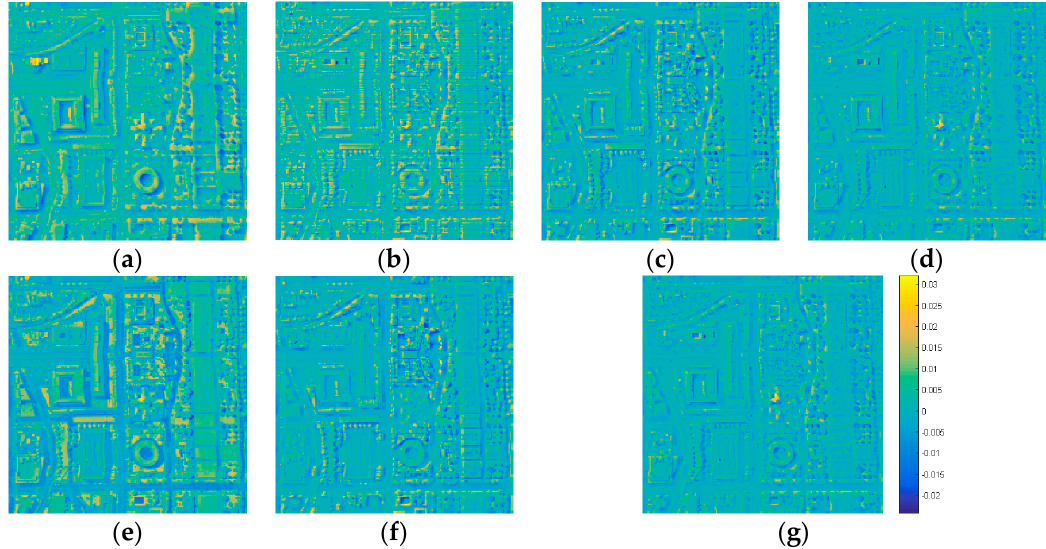
Figure 9. Visual comparison of different hyperspectral pansharpening methods for Washington DC dataset. ( a ) Reference; ( b ) PCA; ( c ) GFPCA; ( d ) HySure; ( e ) MGH; ( f ) CNMF; ( g ) Sparse Representation; ( h ) Proposed.